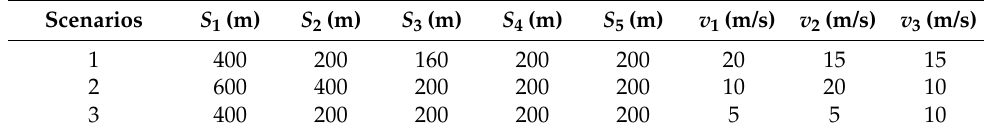
Table 3. The distances and speeds of three